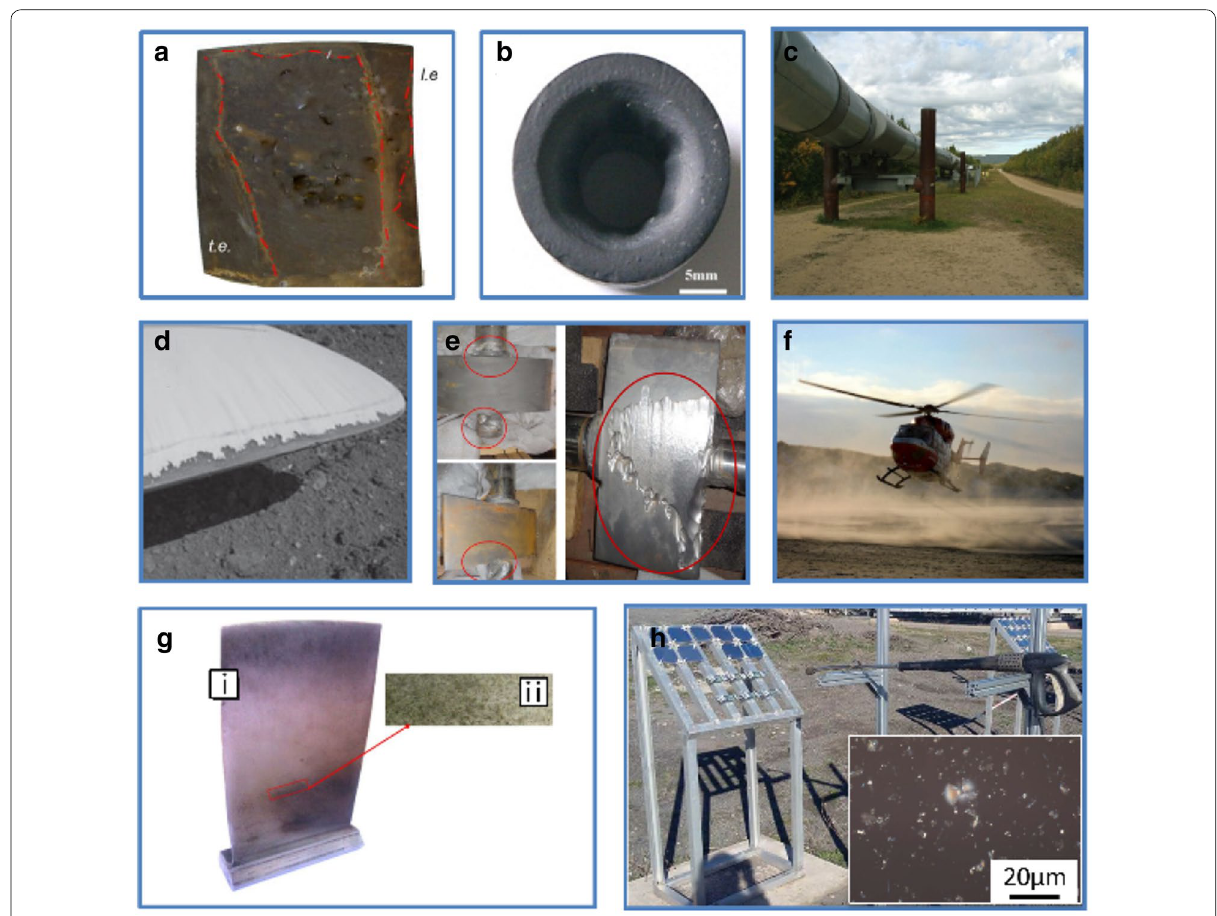
Figure 17 ( a ) The erosion phenomenon of a fan blade [7]; ( b ) The erosion behavior of a ceramic nozzle [138]; ( c ) Conveying pipelines of oil or gas; ( d ) The erosion phenomenon of a wind turbine blade [144]; ( e ) Sediment erosion of hydroelectric generator blades [143]; ( f ) Sand impact on working helicopter blades; ( g ) The erosion phenomenon of a compressor blade: (i) A blade of compressor [149], (ii) Pits caused by solid particle erosion in the critical zone [149]; ( h ) The cleaning setup of antireflective glass coatings eroded by a sandstorm; microscope picture of a sample with antireflective coatings after treatment in the sandstorm chamber (inset)